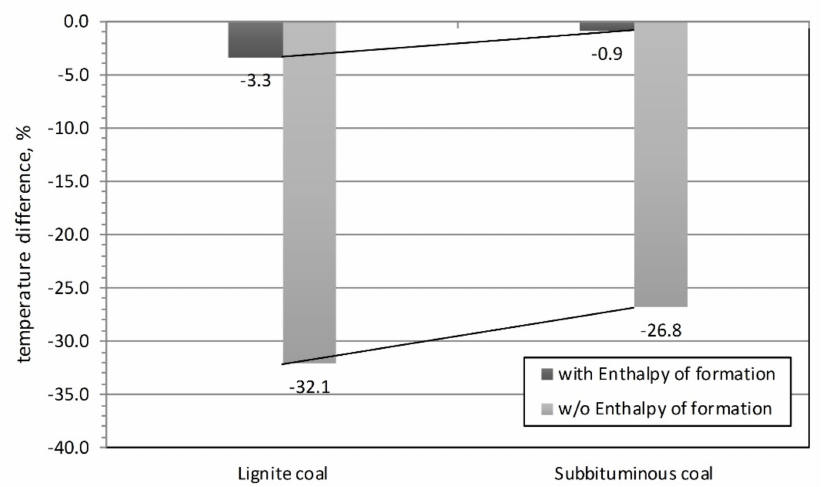
Figure 10. Results of the enthalpy of formation calculations. The heat losses to the environment and the heat necessary to produce medium-pressure steam in the reactor’s shell (sub-bituminous coal and lignite) have been